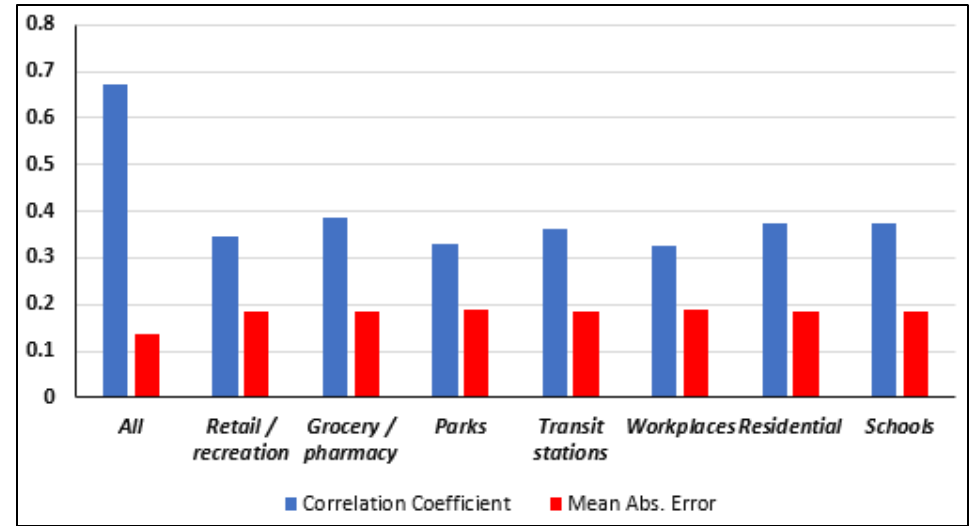
Figure 1. Correlation coefficients for all countries.